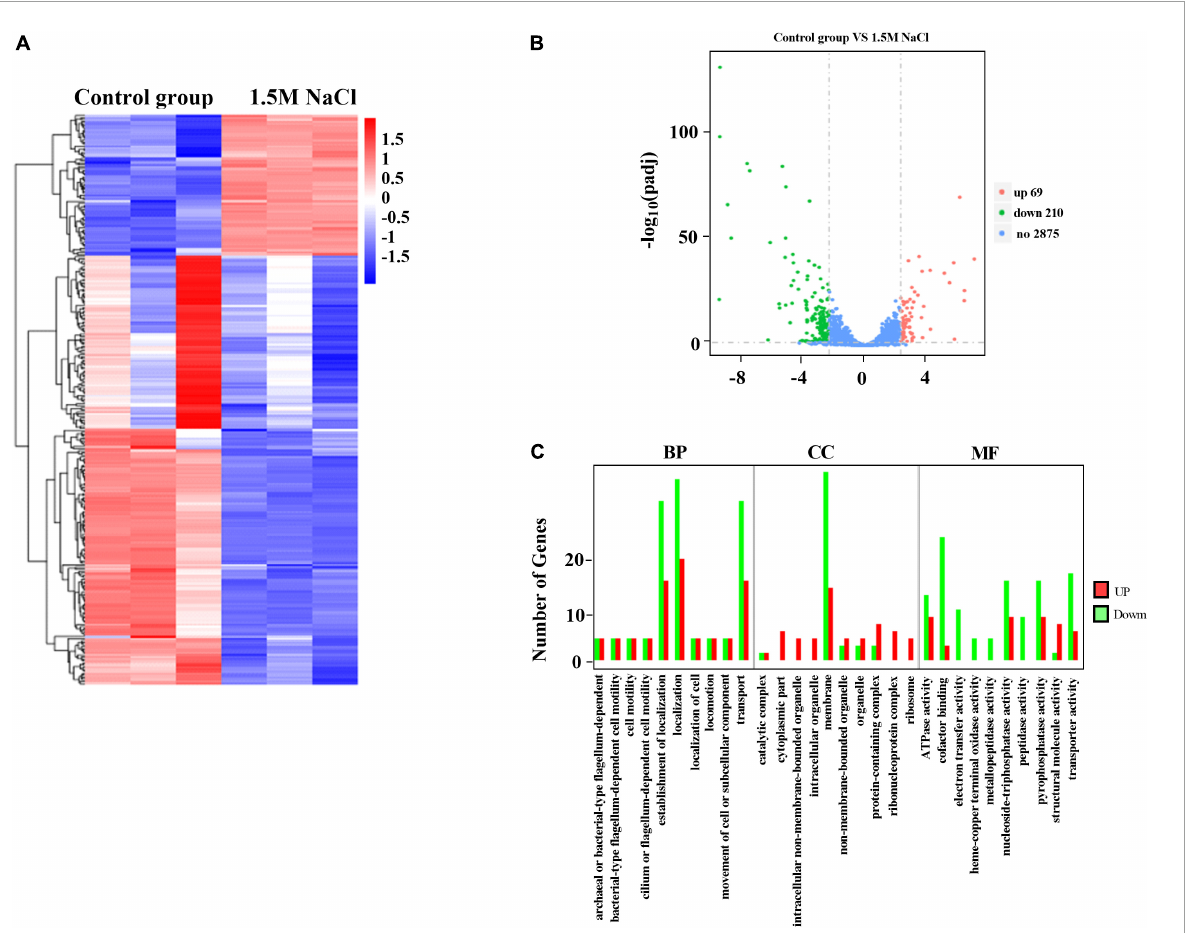
FIGURE3 Expression of differentially expressed genes (DEGs) between the B. melitensis 16M biofilm under 1.5 M NaCl and control conditions. (A) The heatmap shows the expression levels of DEGs between the B. melitensis 16M biofilm under 1.5 M NaCl and control conditions. (B) Volcano plot of expressed genes between B. melitensis 16M biofilm under 1.5 M NaCl and control conditions. The red, green, and blue denote upregulated, downregulated, and non-regulated genes, respectively, in the B. melitensis 16M biofilm under 1.5 M NaCl compared with the control conditions based on the following criteria: absolute log 2 (fold change) ≥ 2 and adjusted P ≤ 0.05. (C) GO terms analysis the number and function of differentially expressed genes (DEGs) between the B. melitensis 16M biofilm under 1.5 M NaCl and control conditions. BP, biological process; CC, cellular component; MF, molecular